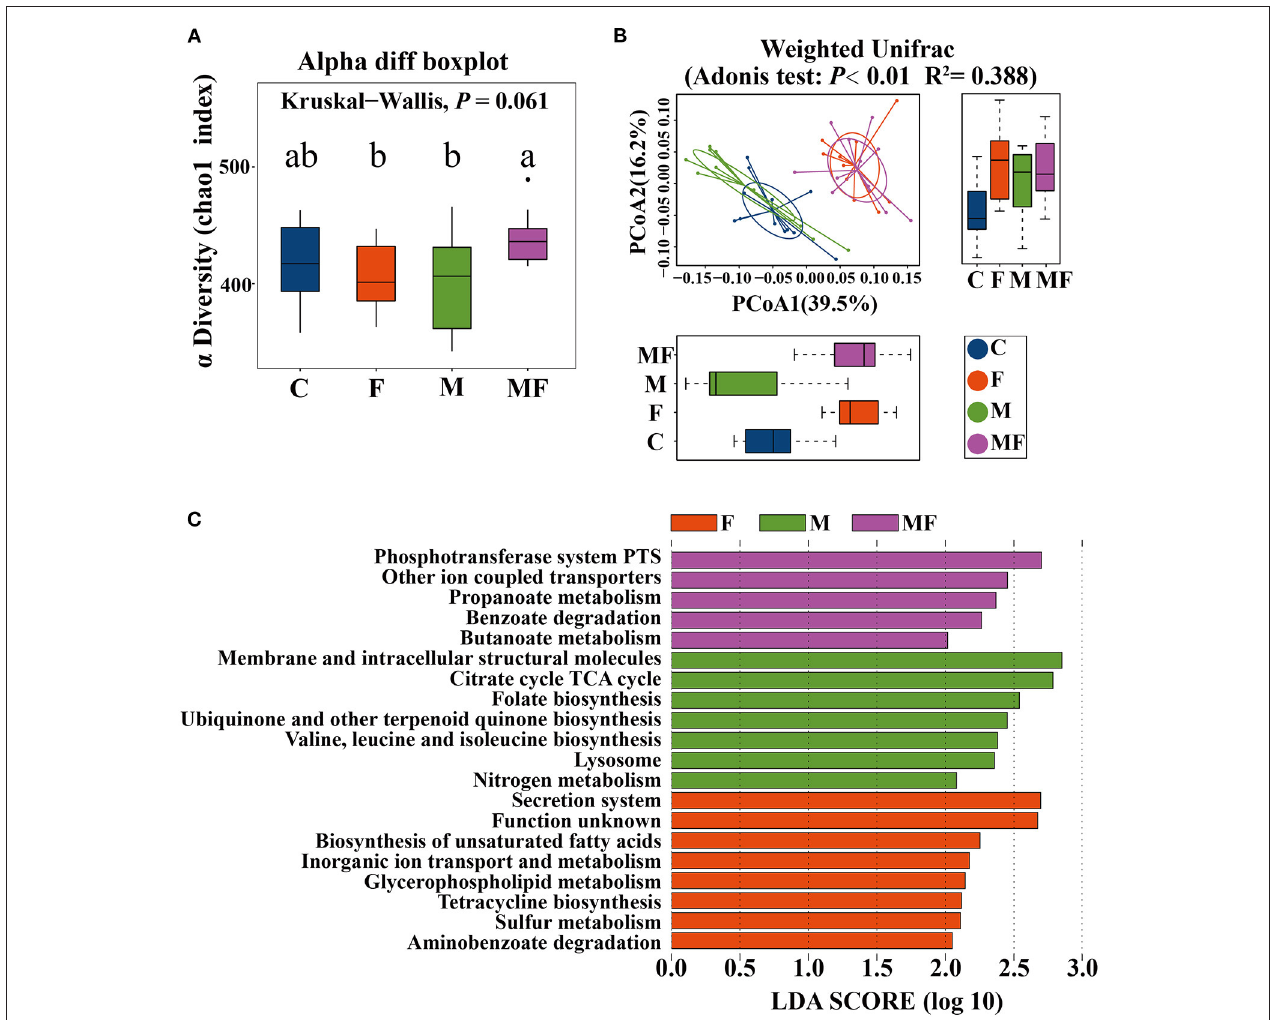
FIGURE 6 | The effects of intermittent fasting and melatonin supplementation on intestinal microbiota in mice. (A) Differences in the α diversity index between groups (Chao 1 diversity index); (B) principal Coordinates Analysis (PCoA) of intestinal microbiota ( β diversity); (C) LEfSe (LDA Effect Size) analysis of KEGG pathway enrichment in different groups, n = 12; Labeled means without a common letter differ ( P < 0.05). C, control; F, intermittent fasting; M, melatonin; MF, intermittent fasting plus melatonin. The C and M mice were fed ad libitum , while the F and MF groups underwent alternative-day feed deprivation. The M and MF groups mice were supplemented with melatonin at a dose of 10 mg/kg body weight by